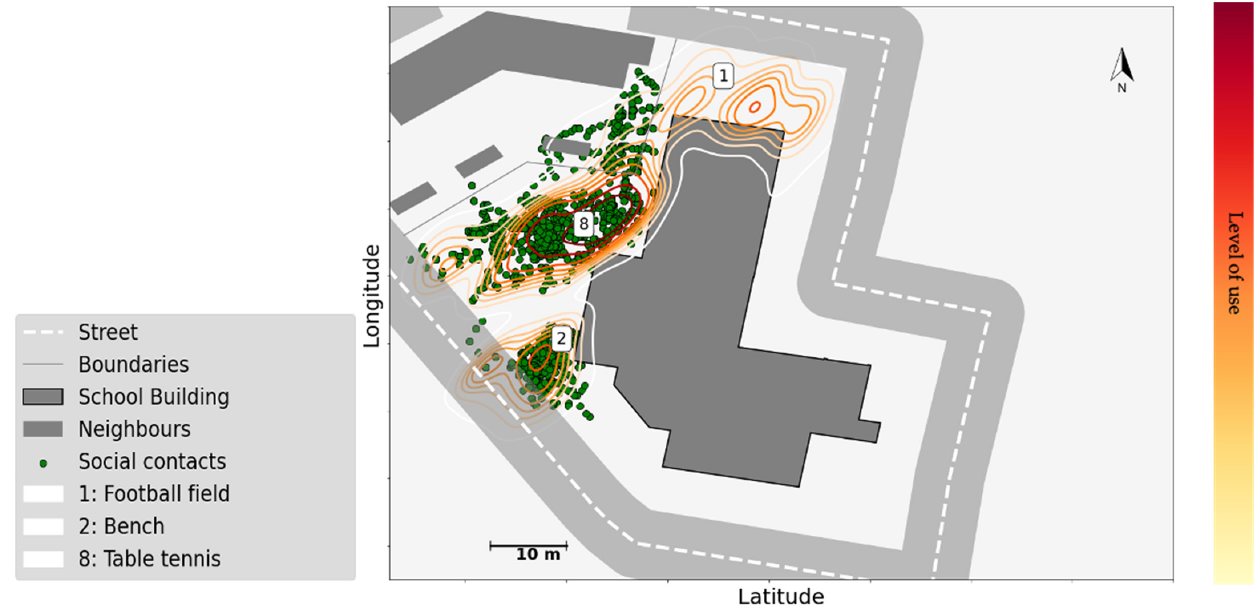
Figure 8. Social use of space by senior classes in school A. The level of use is analysed via GPS data, and obtained contours are colour coded from the lowest level of use to the highest following the colour bar (from yellow to red), face-to-face contacts are extracted from proximity data, fused with GPS locations and mapped to the school floor plan (note that the base station could not cover the contacts that occurred in Area 1, therefore no contacts from that region was registered).